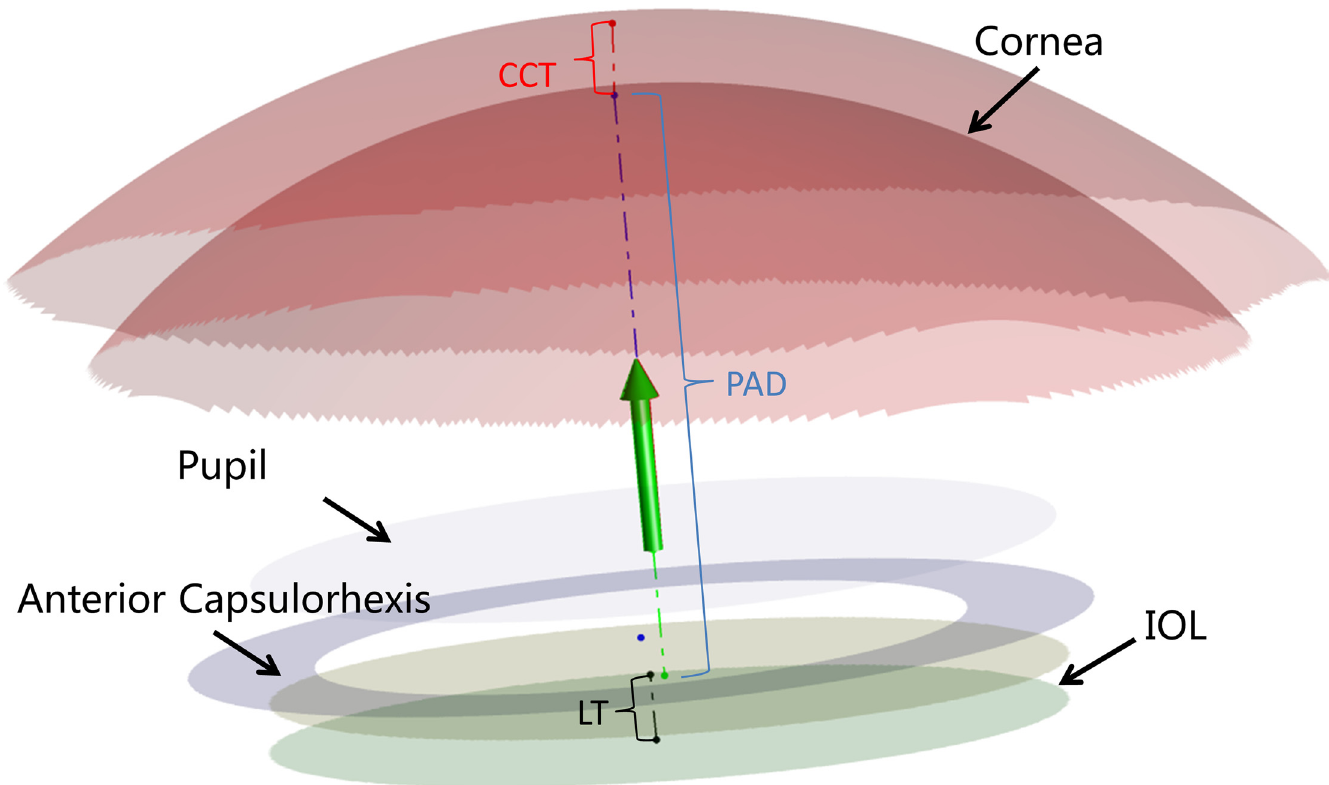
Fig 4. Three-dimensional constructed model of the anterior segment. This image clearly showed the whole anterior segment of the eye, including cornea, anterior chamber, pupil, anterior capsulorhexis, and intraocular lens (IOL). CCT = centre corneal thickness; PAD = postoperative aqueous depth; LT = lens thickness.